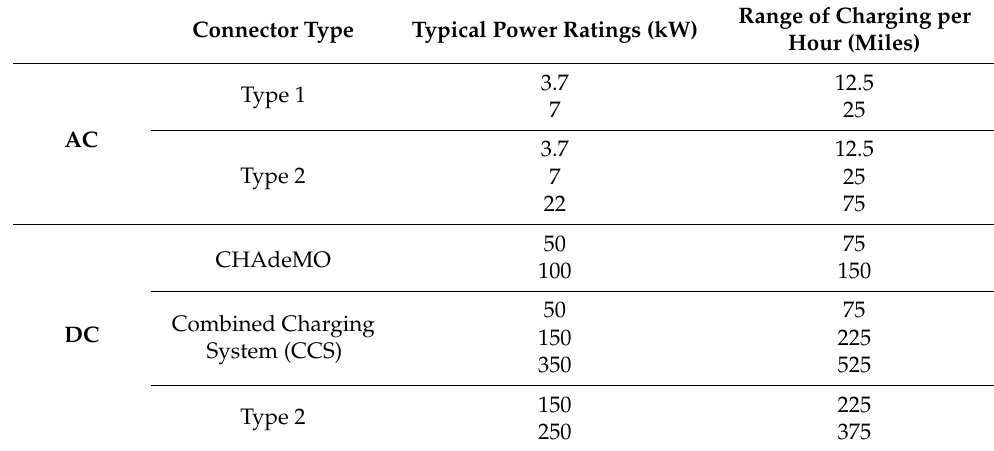
Table 2. Different type of charging outlets and their power ratings.